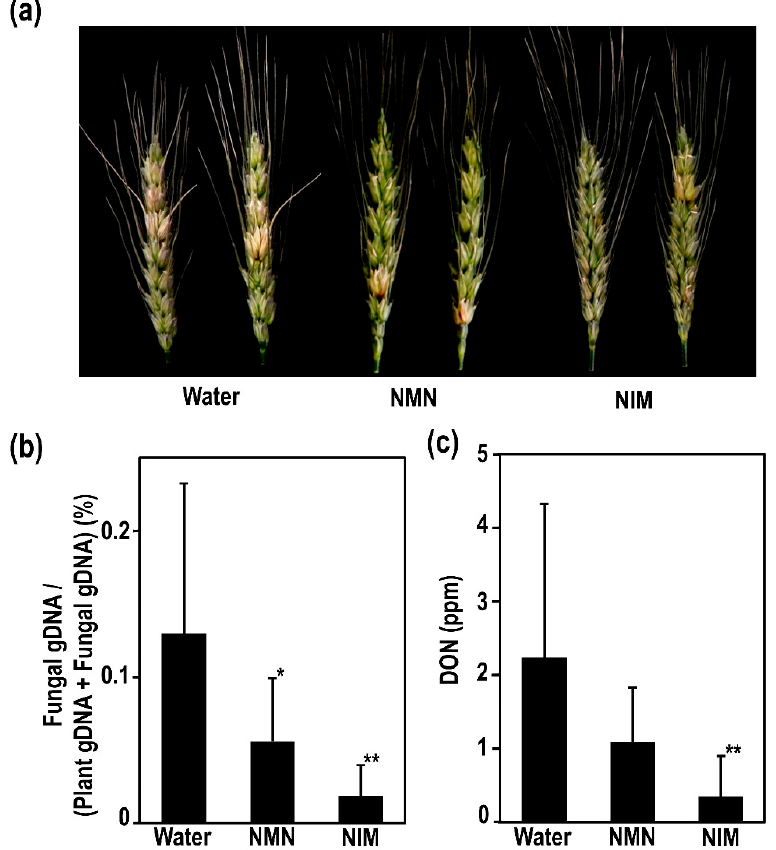
Figure 2. Nicotinamide mononucleotide (NMN) and nicotinamide (NIM) pretreatment enhanced disease resistance against F. graminearum in wheat spikes. NMN or NIM was sprayed onto spikes of susceptible cultivar USU-Apogee before inoculation. A conidia solution with 1x10 4 conidia/mL was applied to these spikes by spraying. ( a ) The representative photographs of inoculated spikes at 7 dpi after water, NMN or NIM pretreatment. ( b ) The ratio of the fungal gDNA to the total gDNA in the water-, NMN-, NIM-pretreated spikes were quantified by qPCR, ( c ) DON accumulations of water-, NMN-, and NIM-pretreated spikes were measured. Each bar represents standard deviation ( n = 12). Student’s t -test: * p < 0.05, ** p < 0.01.